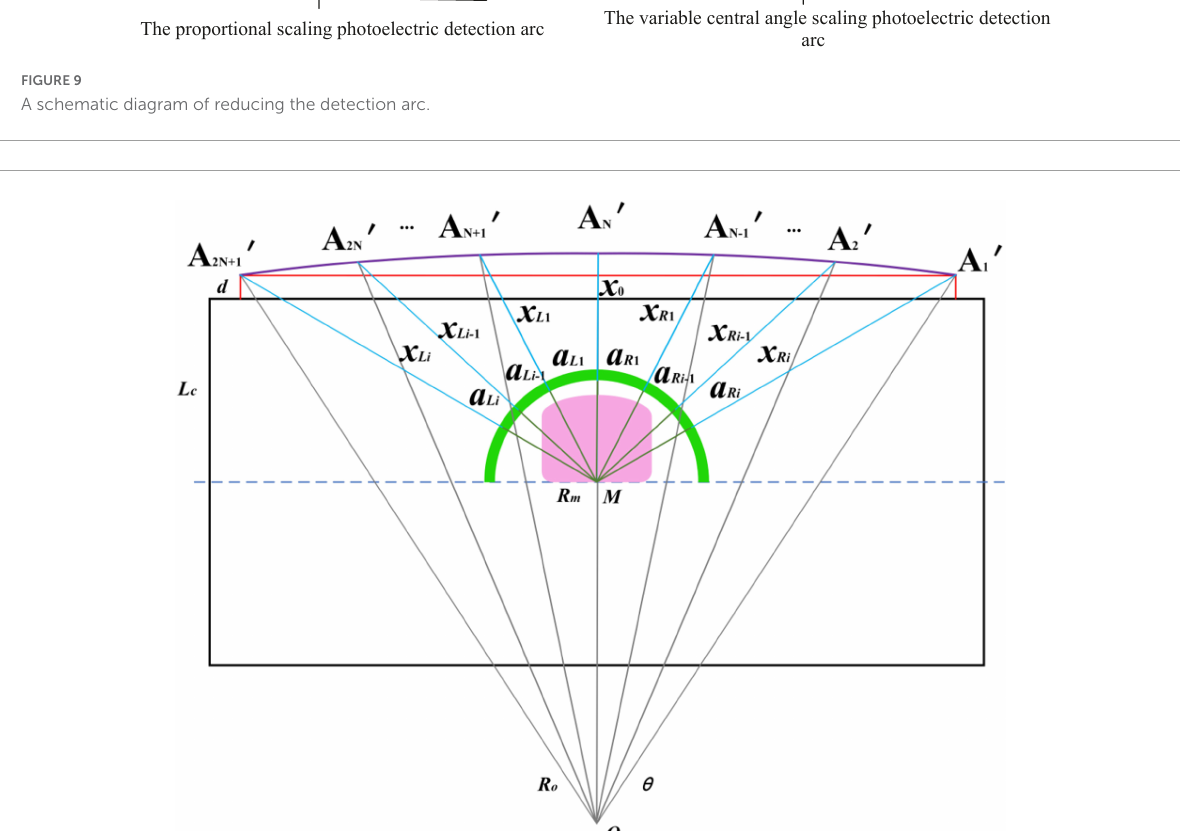
FIGURE10 A coupling adjustment method of reducing the layout radius of ranging sensors, adjusting the center angle of non-equidistant circles and increasing the detection distance: x 0 . Distance detected by sensors at center positions, x Li . Distance detected by sensors at different positions on the left, x Ri . Distance detected by sensors at different positions on the right, a Li . The center angle of the sensor at different positions on the left, a Ri . The center angle of the sensor at different positions on the right, R m . A miniaturized arc array module original radius, R o . An original detection arc radius, A 1 (cid:48) ∼ A 2 N + 1 (cid:48) . An ultrasonic sensor detection